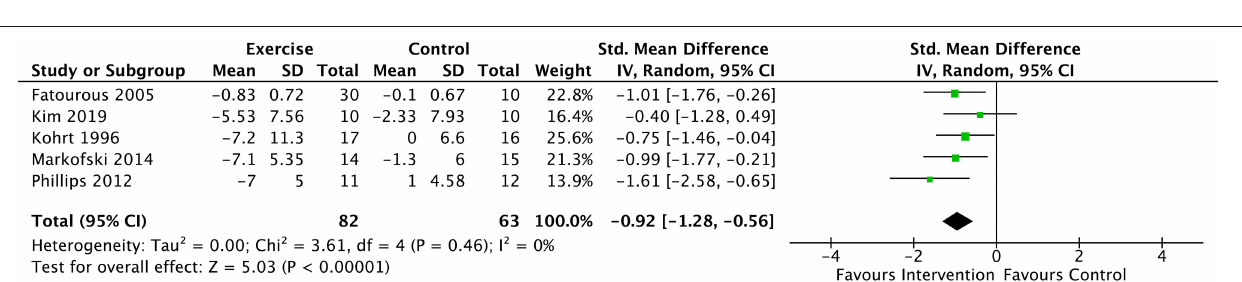
FIGURE 3 | Forest plot for the effect of exercise on leptin. Results favor lower scores in experimental group. Model is statistically significant and homogeneous, suggesting reliability of the large effect size ( − 0.92).